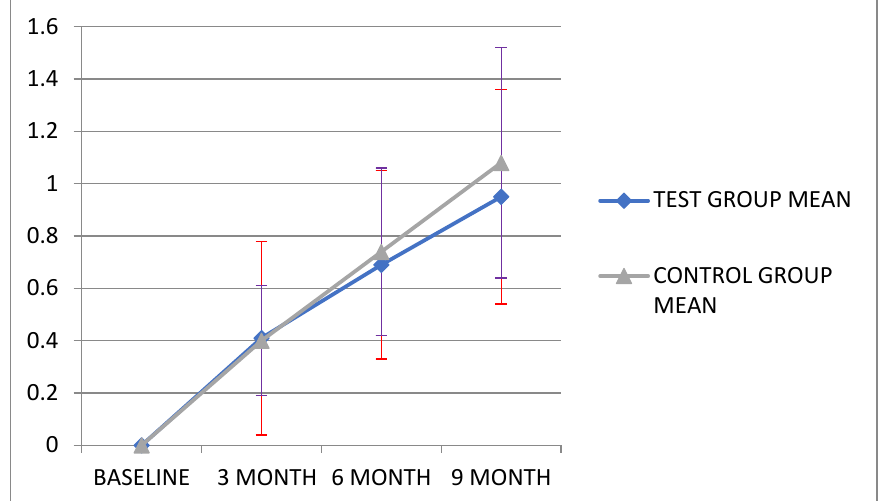
Scheme 1. Intergroup comparison of mean pocket depth (in millimeters).